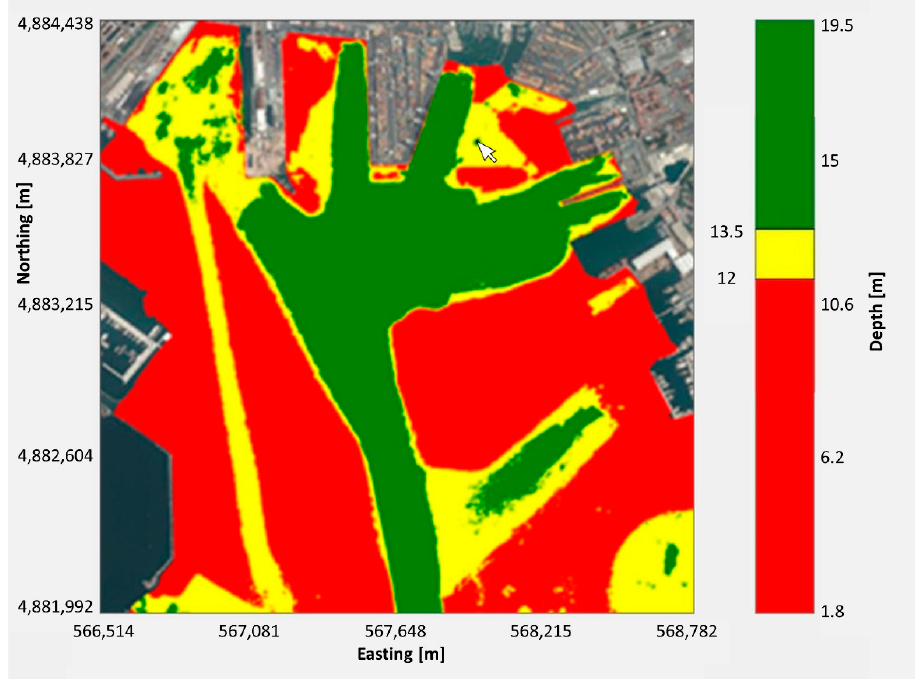
Figure 9. Virtual traffic lights in the port of La Spezia on 24 November 2010 at 18:00 UTC (threshold levels 12 and 13.5 m).